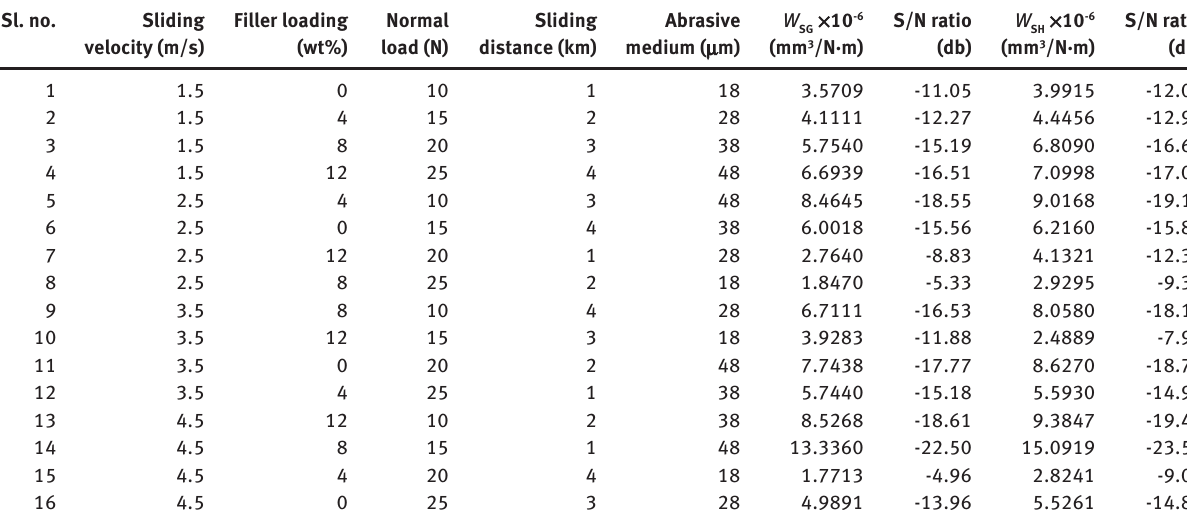
orthogonal array (FGMs and homogeneous composites). 16